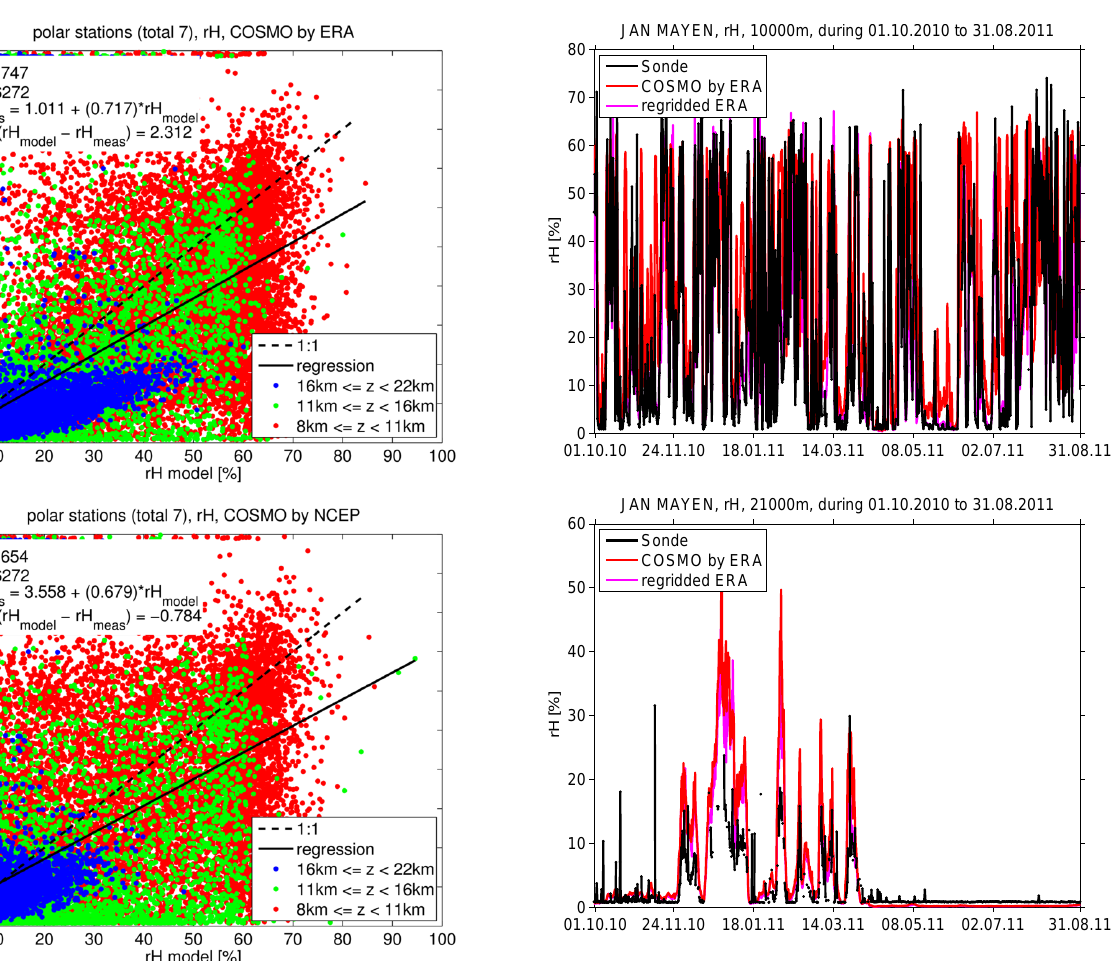
Figure 14. Time series of relative humidity at 10km (top) and 21km (bottom) height above Jan Mayen for the model forced by ERA-Interim